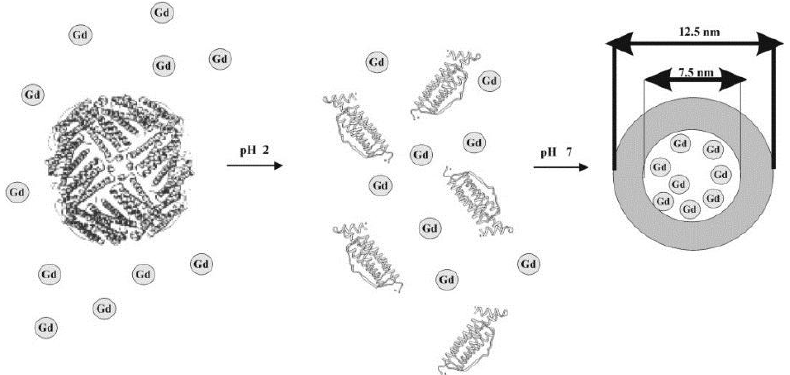
Figure 3. Schematic representation of the dissociation of apoferritin into subunits at pH 2, followed by its reforming at pH 7. In this way, the solution components were trapped within its interior. Reproduced with permission from [30] . Copyright John Wiley and Sons, 2002.